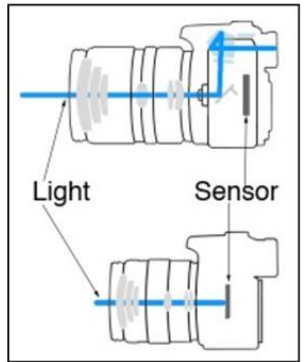
Figure 1. © Working mechanism of mirrored (upper) and mirrorless (bottom) cameras (Url-1, 2017) For mirrored camera, light passing through the lens hits the mirror which is located in front of the sensor and goes from here to the pentaprism which is a special component that allows the view to look straight. Thereafter, light reaches the optical viewfinder. At the moment of shooting, the mirror lifts and the light falls into sensor (Url-2, 2017). There is no mirror mechanism in the mirrorless camera. Therefore, the light passing through the lens directly reaches the sensor. In mirrorless cameras, electronic viewfinder is used instead of optical one. Optical viewfinder transmits the frame seen by the camera to the eye with the help of objective and prisms. However, electronic viewfinder transmits the photograph to be taken by the camera